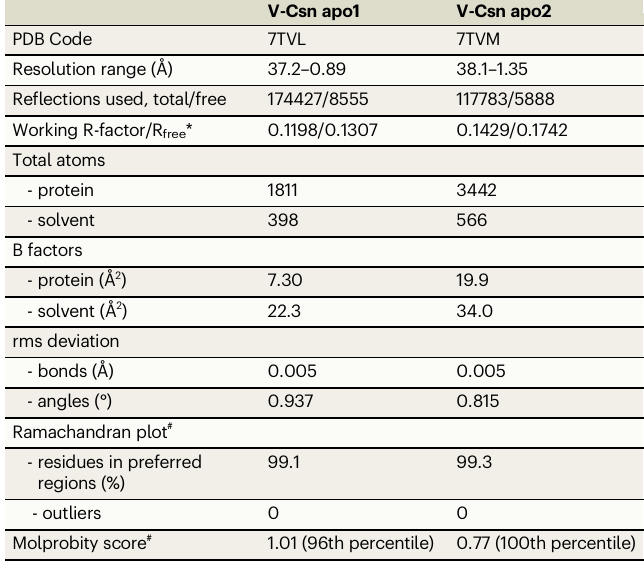
Table 2 | Wild-type V-Csn structure re fi nement